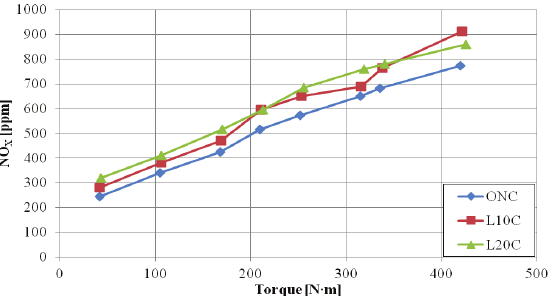
Fig. 4. NO x concentration for injection timing C and n = 1400